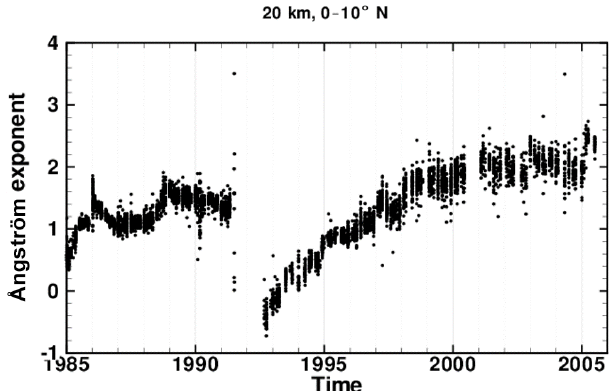
Figure 7. Ångström exponent α( 525 / 1020 ) derived from SAGE II SOT measurements during its measurement history. This pic- ture corresponds to measurements at altitude 20km for the 0– 10 ◦ N latitude bin. Cases for which the measured aerosol extinc- tion at 1020nm < 4 × 10 − 6 km were excluded from this analysis (L. Thomason, private